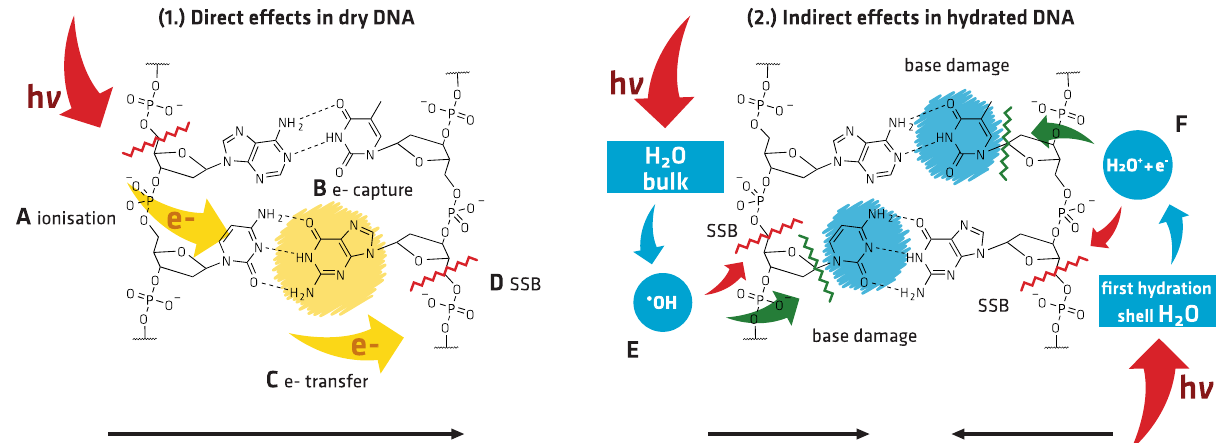
Fig. 5 Overview of the most important (1.) direct and (2.) indirect damage mechanisms. In dry DNA (1.) direct effects produce mostly SSB (red lines) via ionization events ( A ) of DNA (red arrows) or by LEE via the formation of TNI at the bases ( B ), subsequent transfer to the backbone ( C ), and rupture of C – O bond ( D ). In contrast, a shift toward base damage is observed in hydrated DNA (2.). Here, indirect damage channels contribute to the increase of the overall radiation damage. Ionization of water molecules in the bulk ( E ) or in the fi rst hydration ( F ) layer represents the most important processes. Direct processes are present in hydrated DNA, but are not shown for simplicity. Green lines represent base loss. For details see the